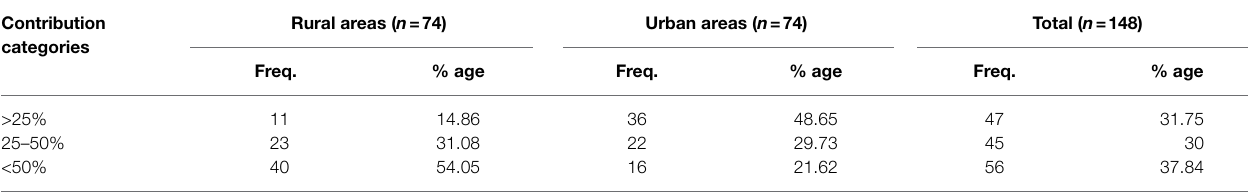
Source: Authors calculations form survey data.